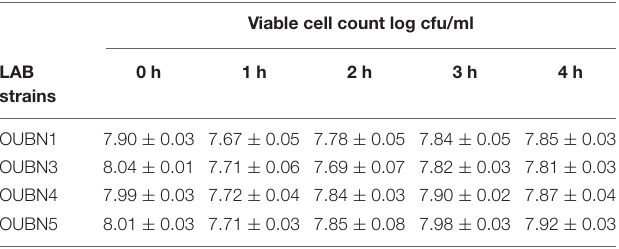
TABLE 4B | Viable cell count log cfu/ml of LAB survived in MRS after 0, 1, 3, and 4 h in the presence of 0.3% bile salts.